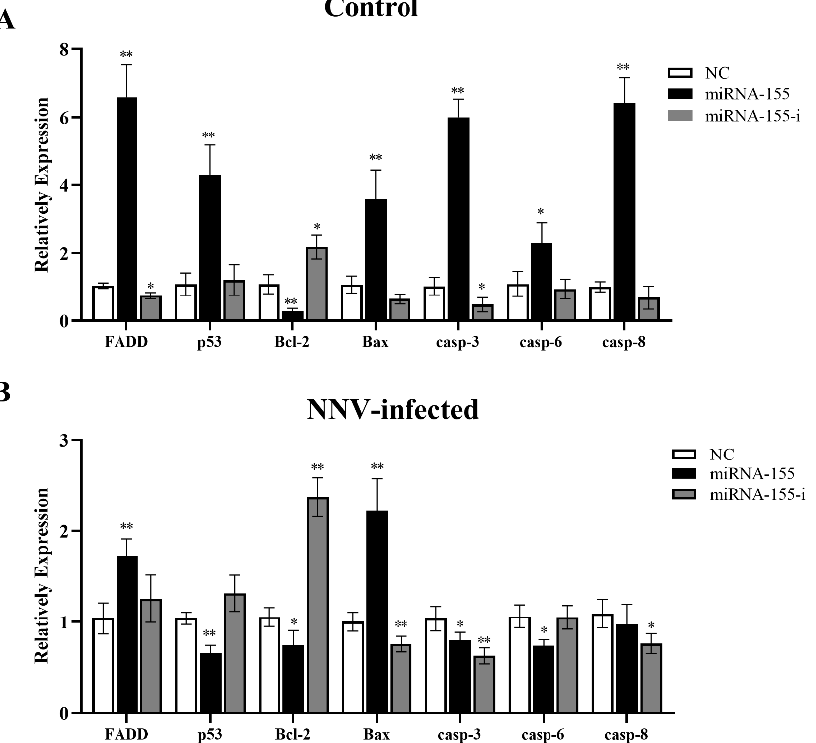
Figure 7. cal-miR-155 affects the mRNA expression of apoptosis-related genes in CAB cells. CAB cells were transfected with a cal-miR-155 mimic and an inhibitor for 24 h, then the cells were infected with NNV (MOI = 10), as described. After 24 h, the cells were harvested, and apoptosis-related genes, FADD, p53, Bcl-2, Bax, and Caspase-3/6/8, were detected in cells infected with NNV ( B ) or not ( A ). EF- α was selected as the reference gene. Data in this assay are expressed as mean ± SD ( n = 3). (** stands for p < 0.01; * stands for p < 0.05.).